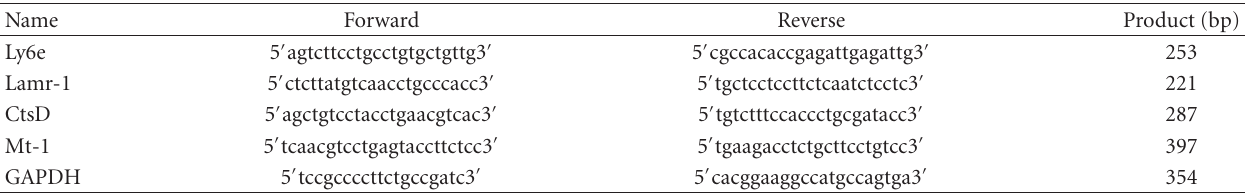
Table 2: PCR gene sequences in four candidate genes and housekeeping